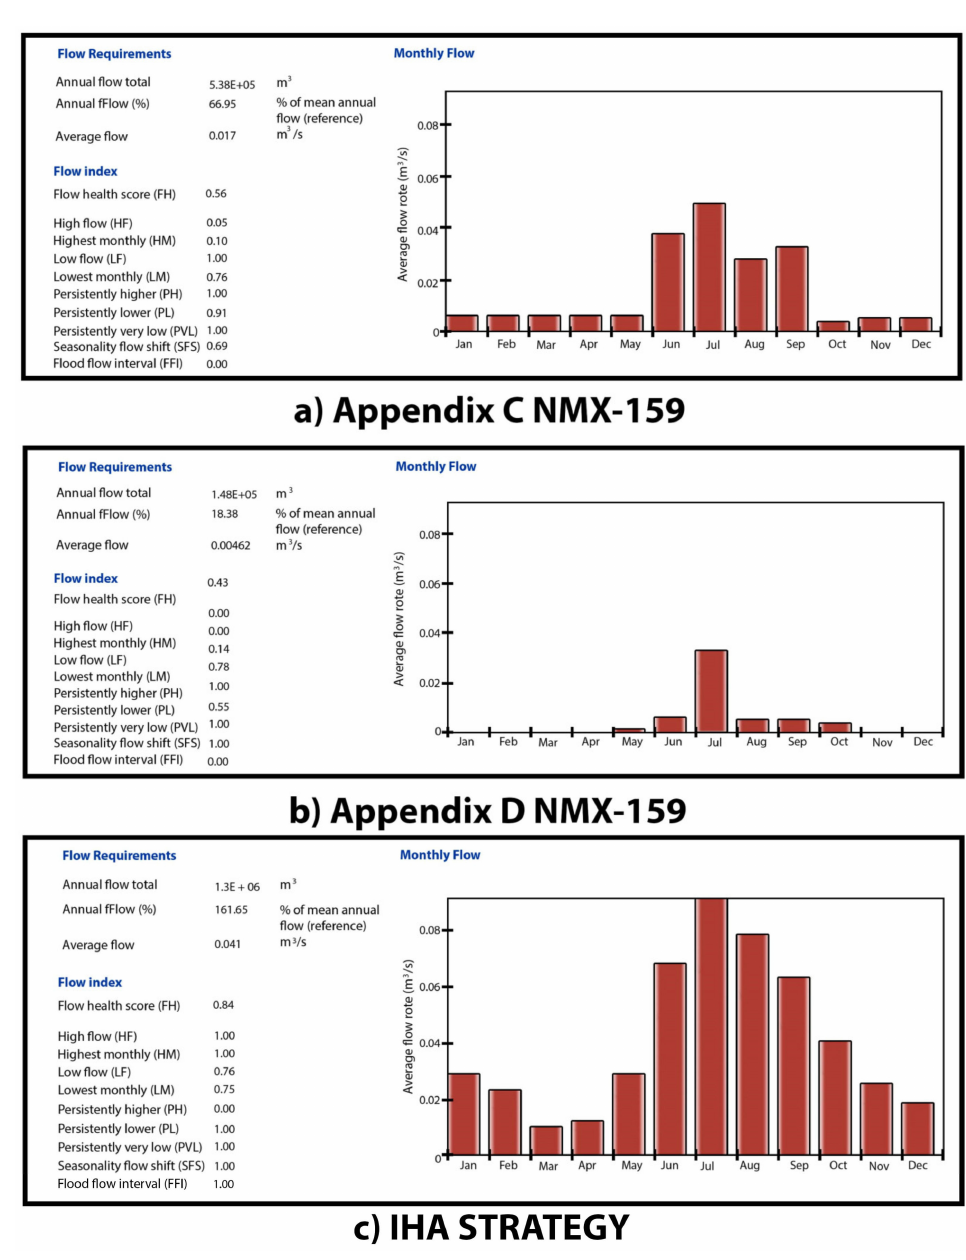
Figure 12. Assessment strategy of environmental